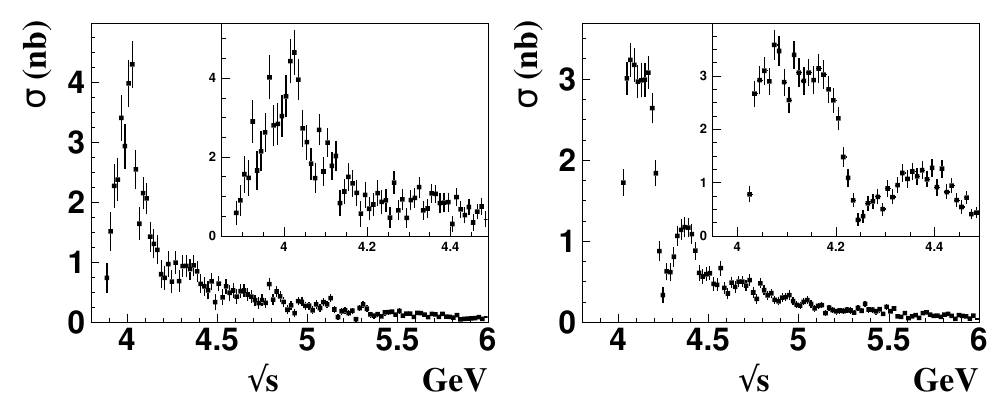
D + D ∗− (left) and e + e − D ∗ + D ∗− → →